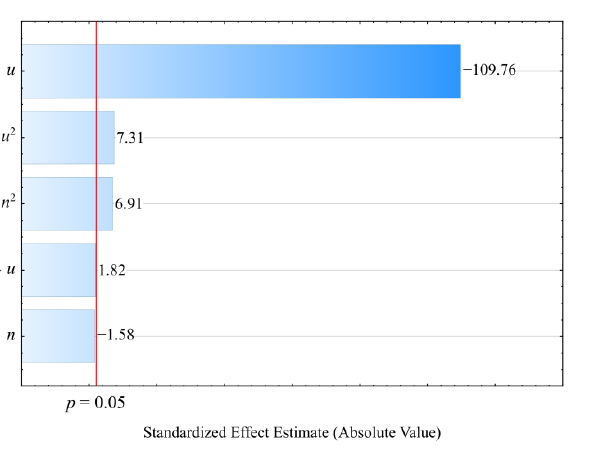
Figure 20. Pareto plots of the standardized effects of empirical full model tensile strength σ ; the vertical line in the plot corresponds to the arbitrarily chosen level of significance ( p = 0.05).